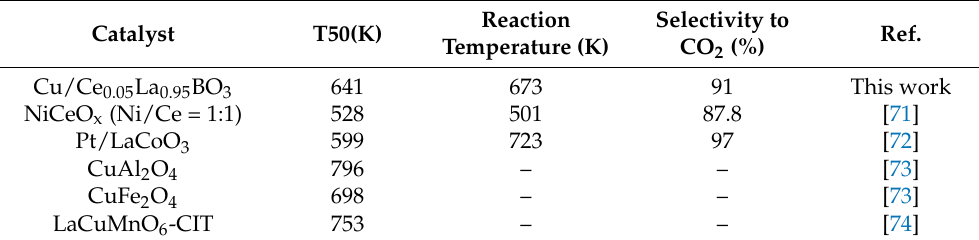
Table 5. The CO 2 selectivity of the propane combustion catalyzed by Cu/Ce 0.05 La 0.95 BO 3 and other reported catalysts. Reaction Selectivity to Ref. Catalyst T50(K) Temperature (K) CO 2 (%) 641 673 91 This work NiCeO x (Ni/Ce = 1:1) 528 501